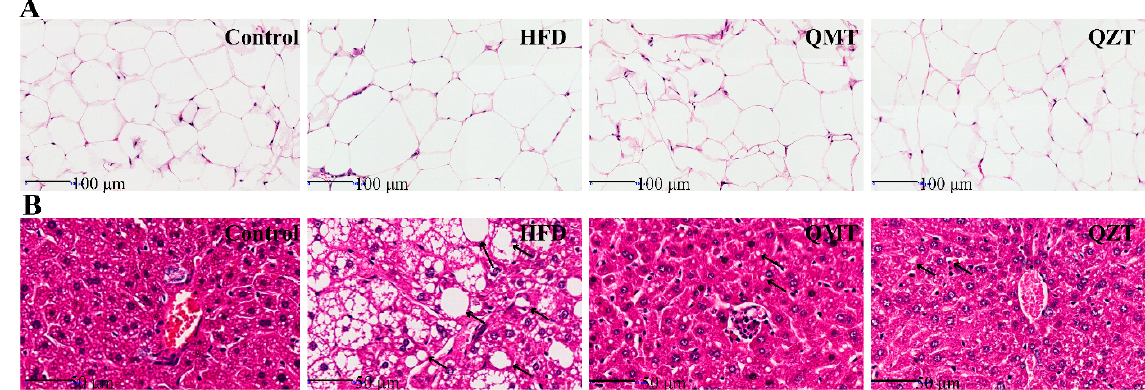
Figure 2. The histopathological change of subcutaneous fat ( A ) and liver ( B ) in each group of mice after 10-week tea intervention.